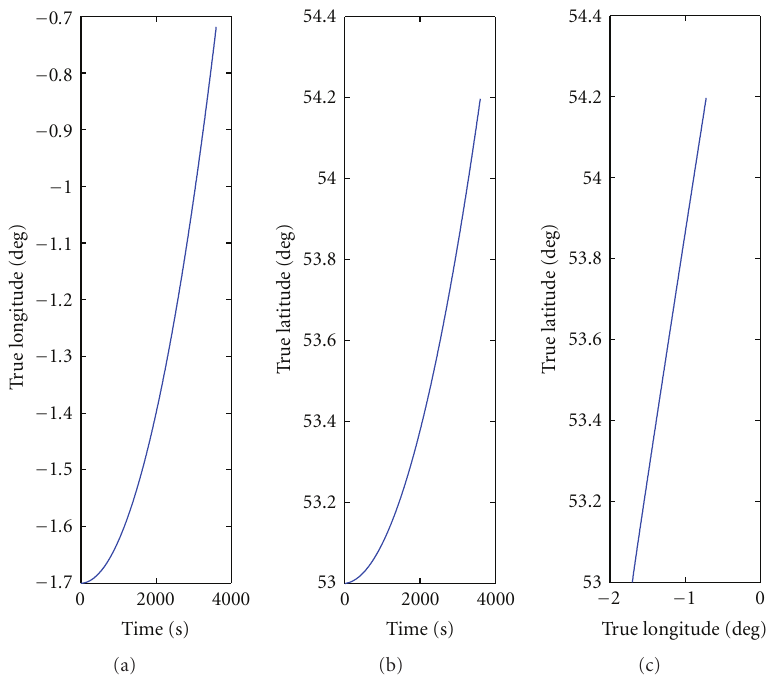
Figure 12: The designed trajectory of straight line